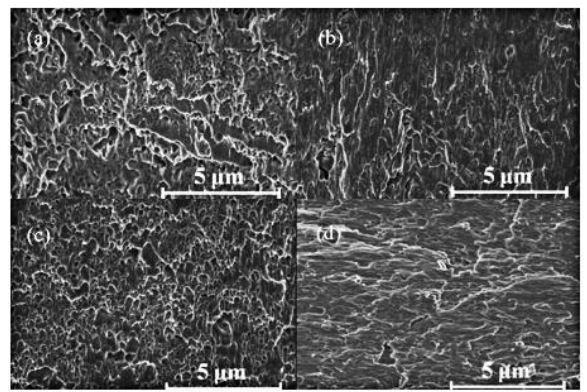
Figure 8. Fracture surfaces of samples sintered with different current: ( a ) 5.50 kA; ( b ) 6.50 kA; ( c ) 7.00 kA; ( d ) 8.25 kA. Reproduced with permission from [161].